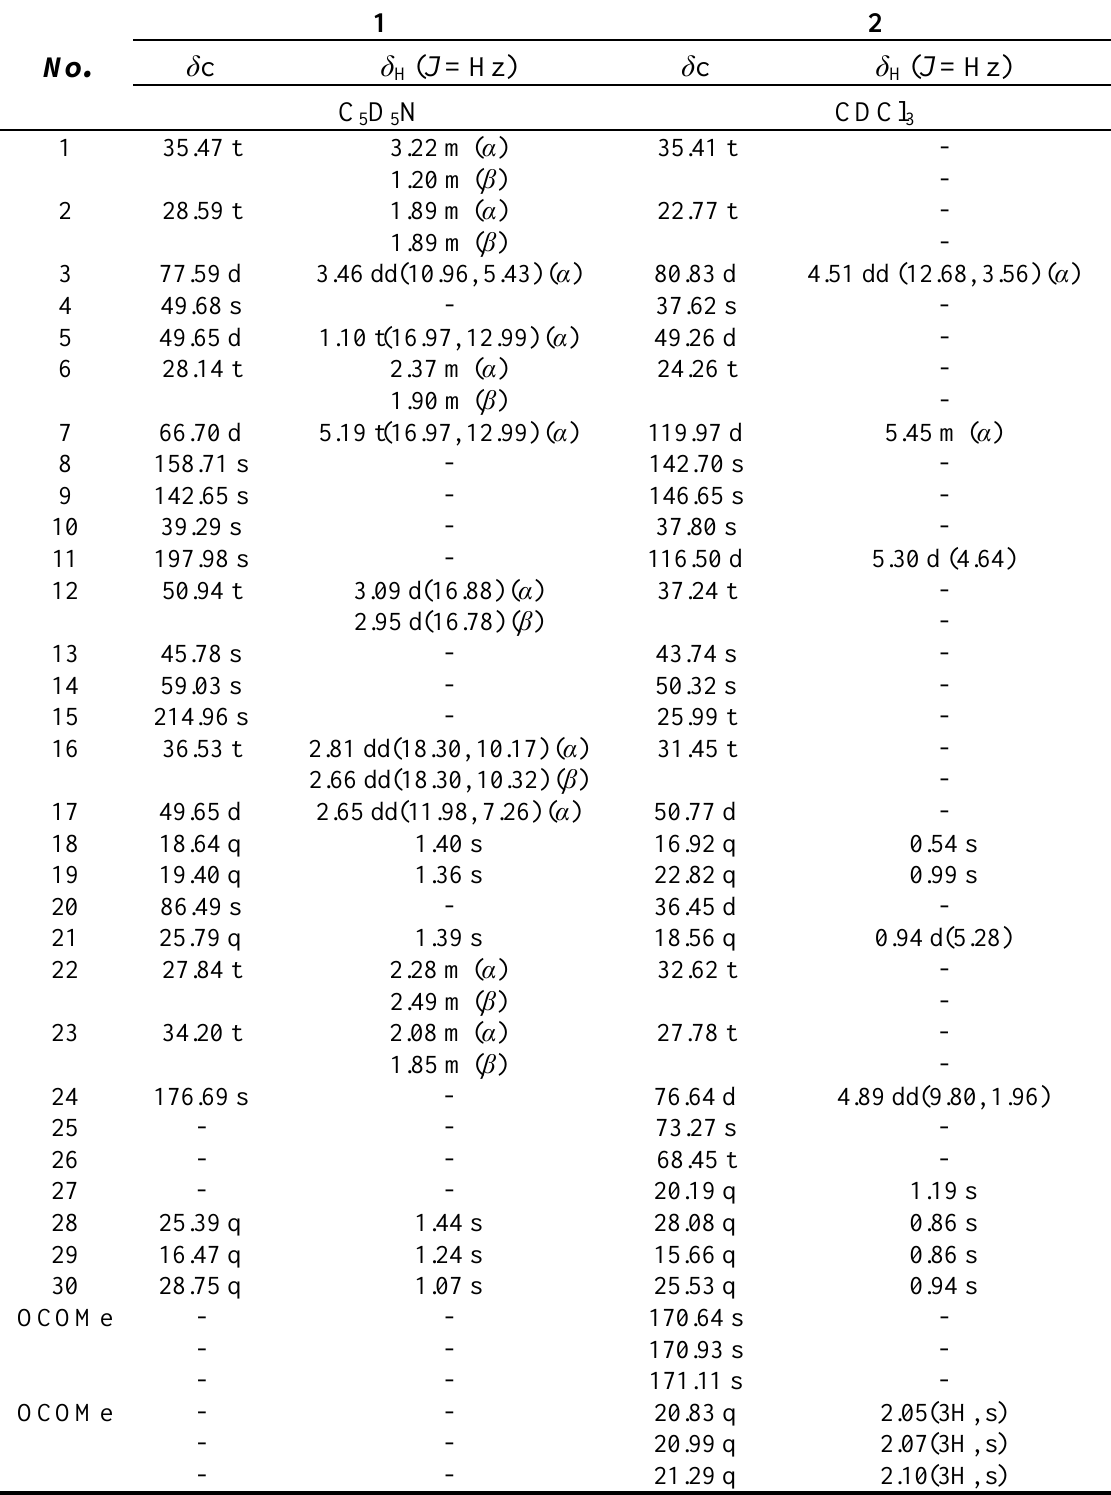
Table 1. 1 H-NMR and 13 C-NMR data of compounds 1 and 2